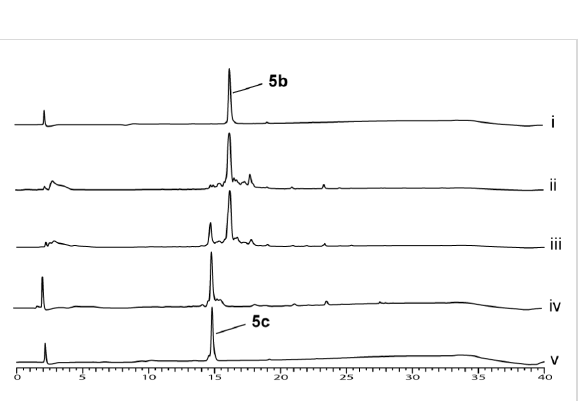
Figure 7: HPLC trace overlay and MS analysis of the somatostatin an- alogue, 1SW-1 , which was N α -methylated on solid support at three dif- ferent sites. Red: N α -methylations were performed using the state-of- the art procedure. Green: N α -methylations were performed using the DMAP-assisted procedure reported